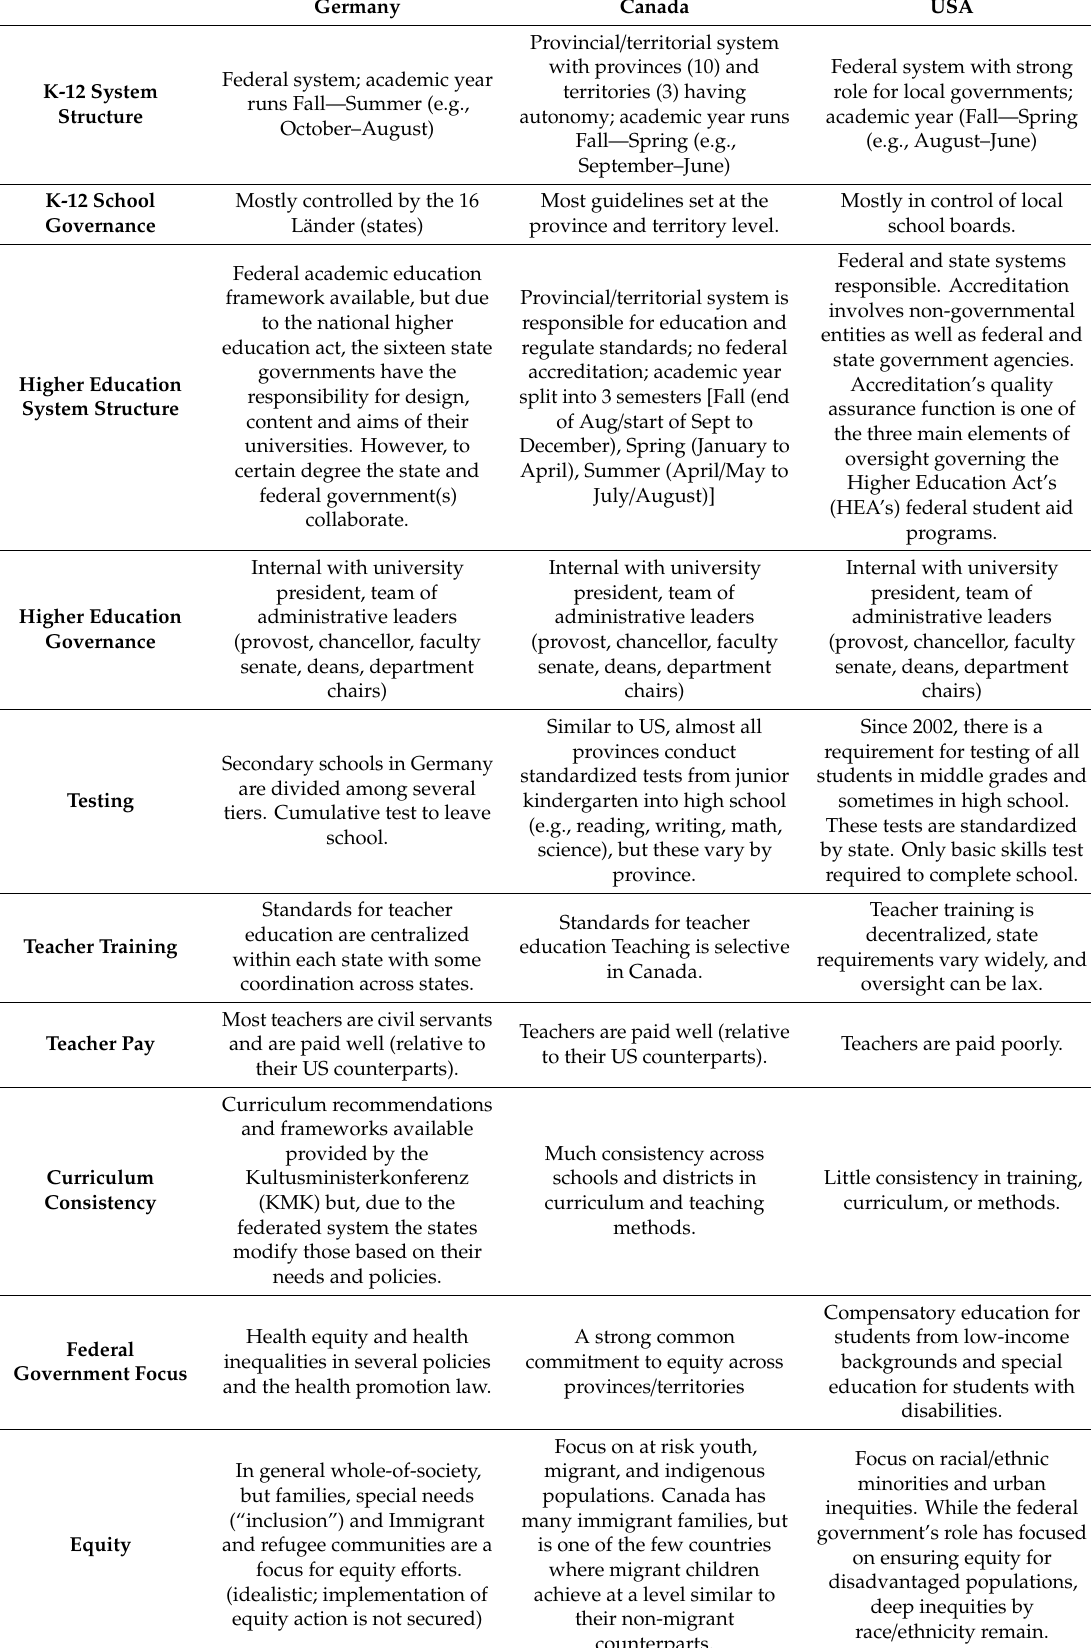
Table 1. Comparison of educational structures in Germany, Canada, and USA with relevance for the education for health literacy